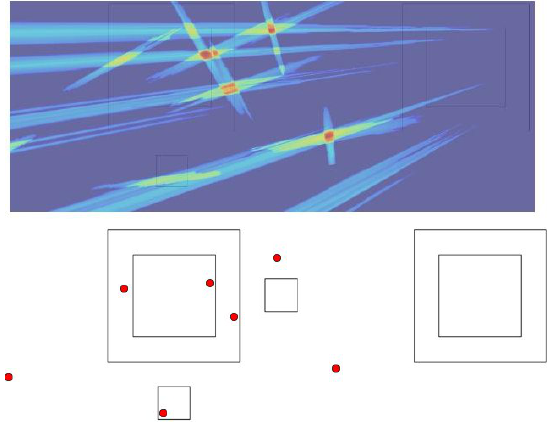
Fig. 5. Detection results for multiple people detection using the homography constraint. The top image show the accumulation result, and the bottom image shows the location of the detected people from the computation of local maxima [16].